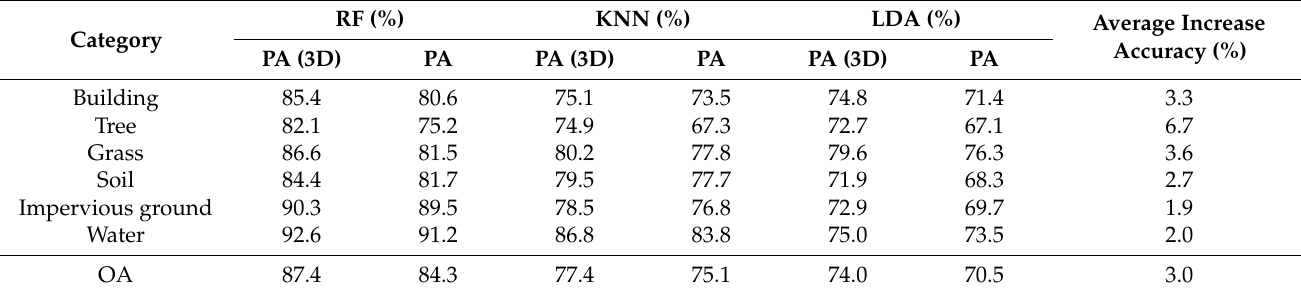
Table 7. Comparison of land-cover classification by using 3D USPs against those by using only 2D features. Category